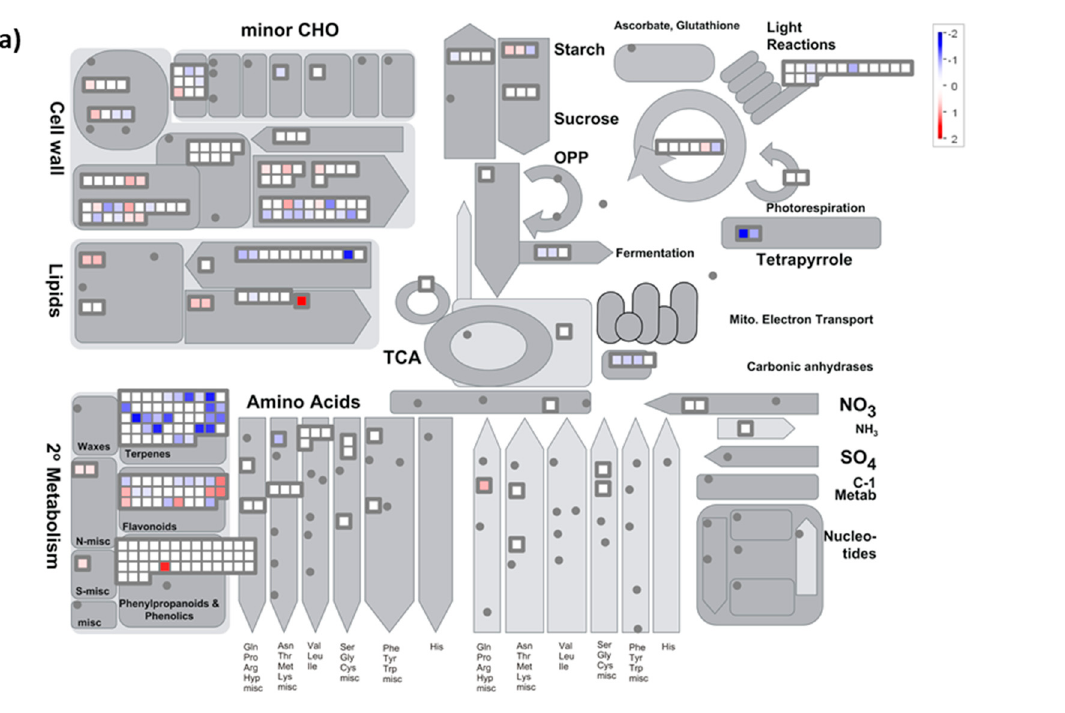
Figure 5. Mapman visualization of the metabolism overview pathway modulation at ( a ) 8 h and ( b ) 2 h PS. 2.5.2. Cold Stress Affects the Expression of Genes Encoding Transcription Factors Involved in the Circadian Clock In response to the cold night, the functional category concerning the TFs family of “Pseudo Arabidospsis thaliana response regulator (ARR)” (BIN 27.3.66) was over-expressed ( p -value = 4.7 ×